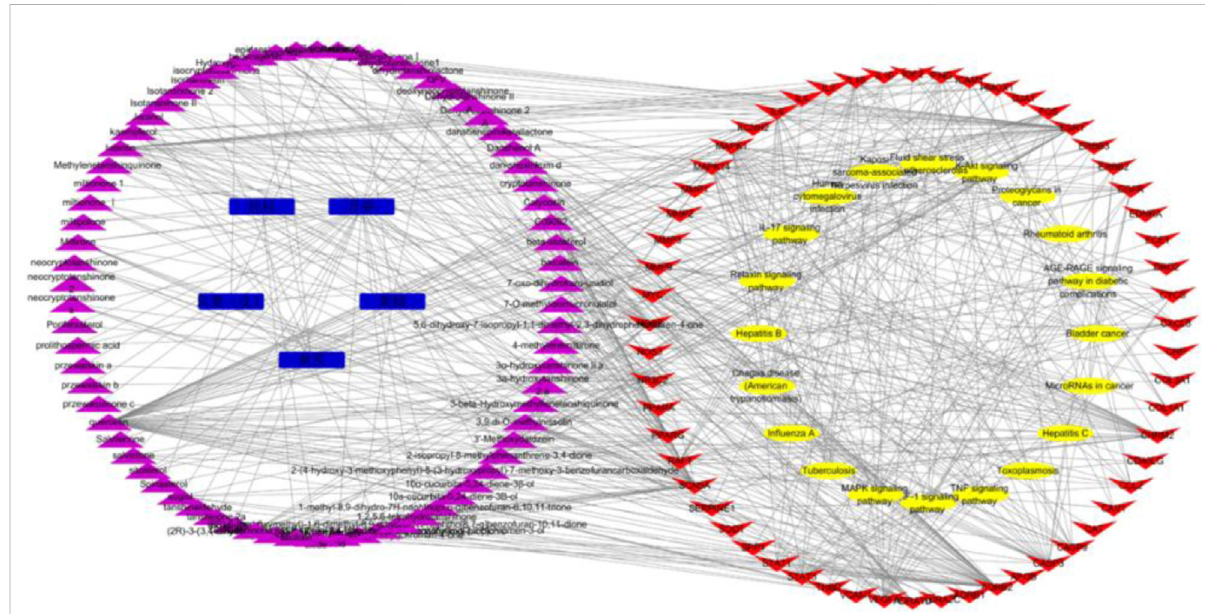
FIGURE 4 Medicinal material-component-target-signal pathway network. Blue nodes represent the 5 principal components of KXF, purple nodes represent active compounds, red nodes represent relative genes, and yellow nodes represent signaling pathways. 黄 芪 : Astragalus mongholicus Bunge (Huangqi), 黄 精 : Polygonatum kingianum Collett and Hemsl (Huangjing), 丹 参 : Salvia miltiorrhiza Bunge (Danshen), 桂 枝 : Neolitsea cassia